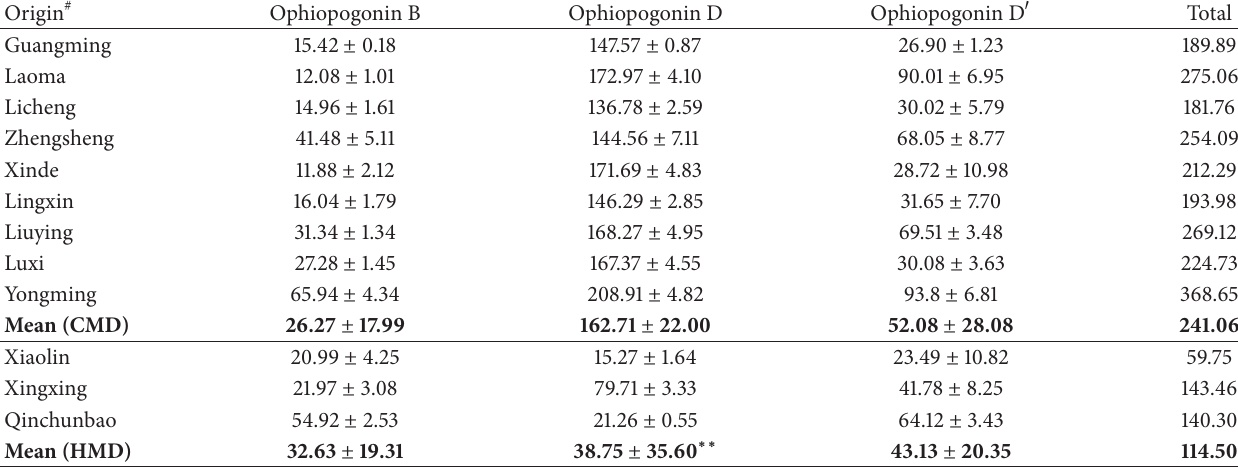
Table 2: The content of three saponins in fibrous roots of HMD and CMD ( 𝜇 g/g).